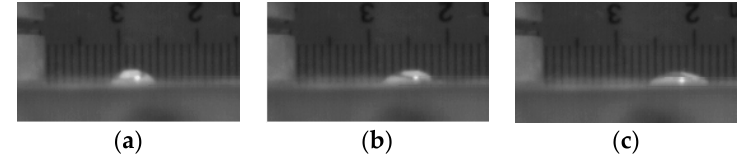
Figure 16. The deformation characteristic of droplet under DC negative polar power source.